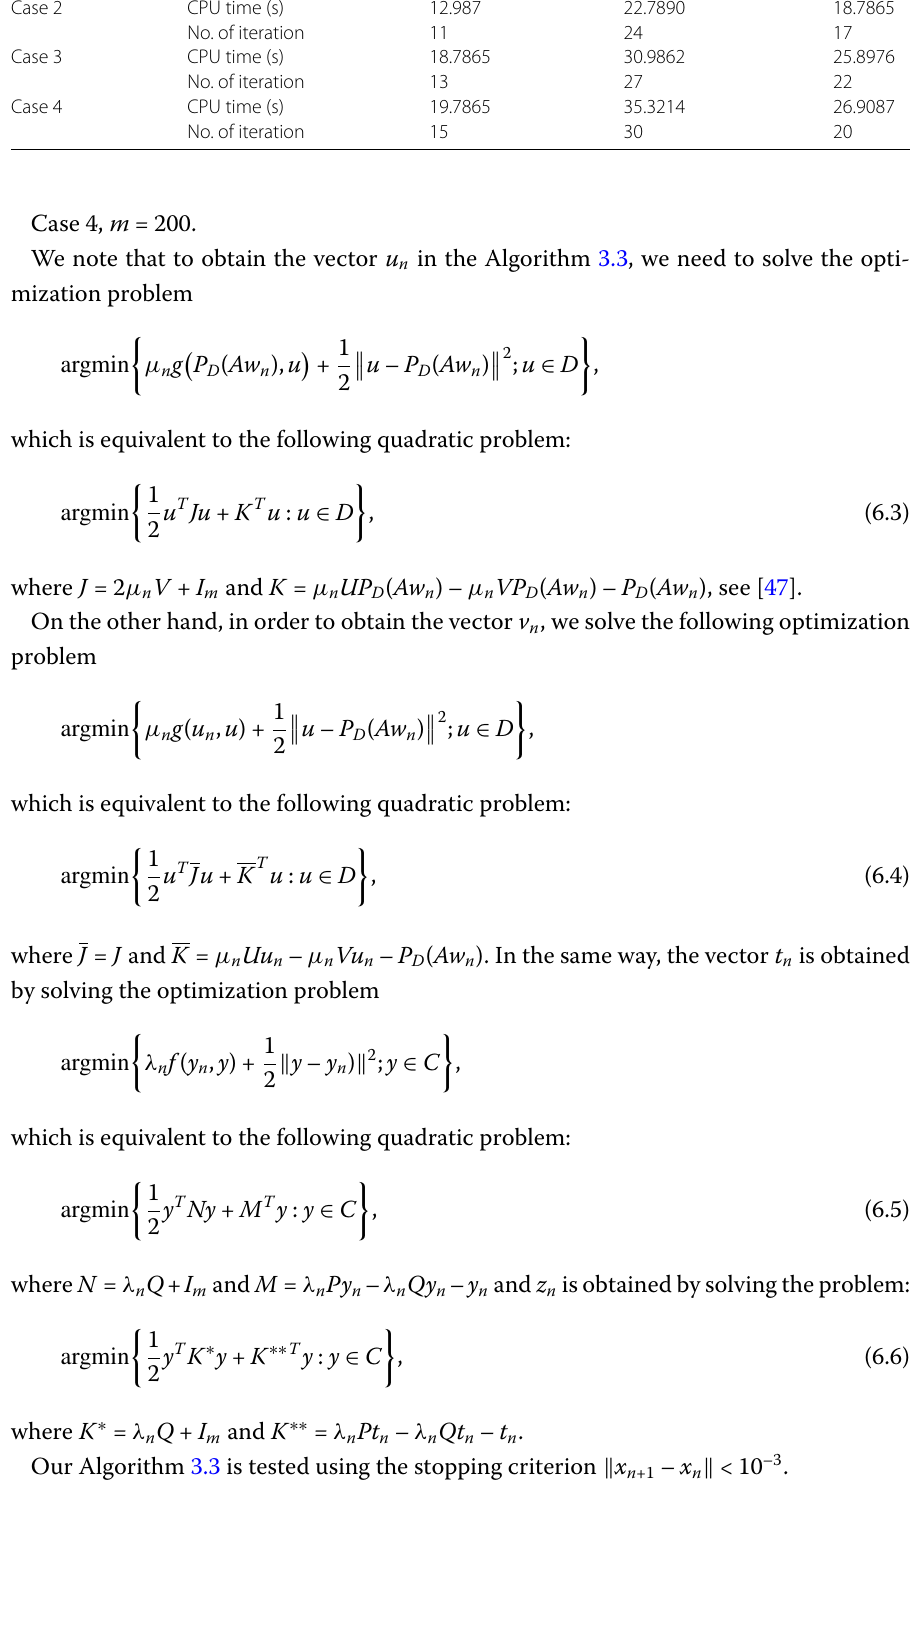
Table 1 Numerical results comparing the Algorithms and their time of convergence and number of iterations Alg. 3.3 Alg. (1.10) Alg. (1.11) Case 1 CPU time